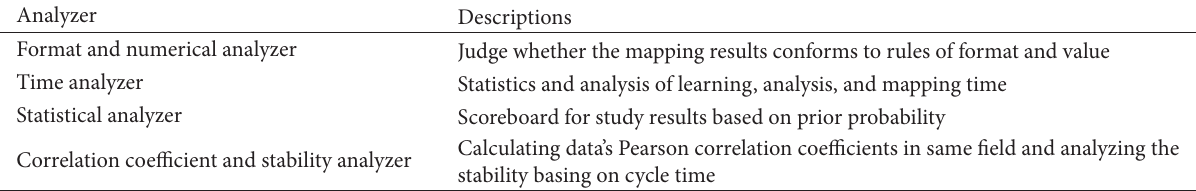
Table 2: List of analyzers’ type.